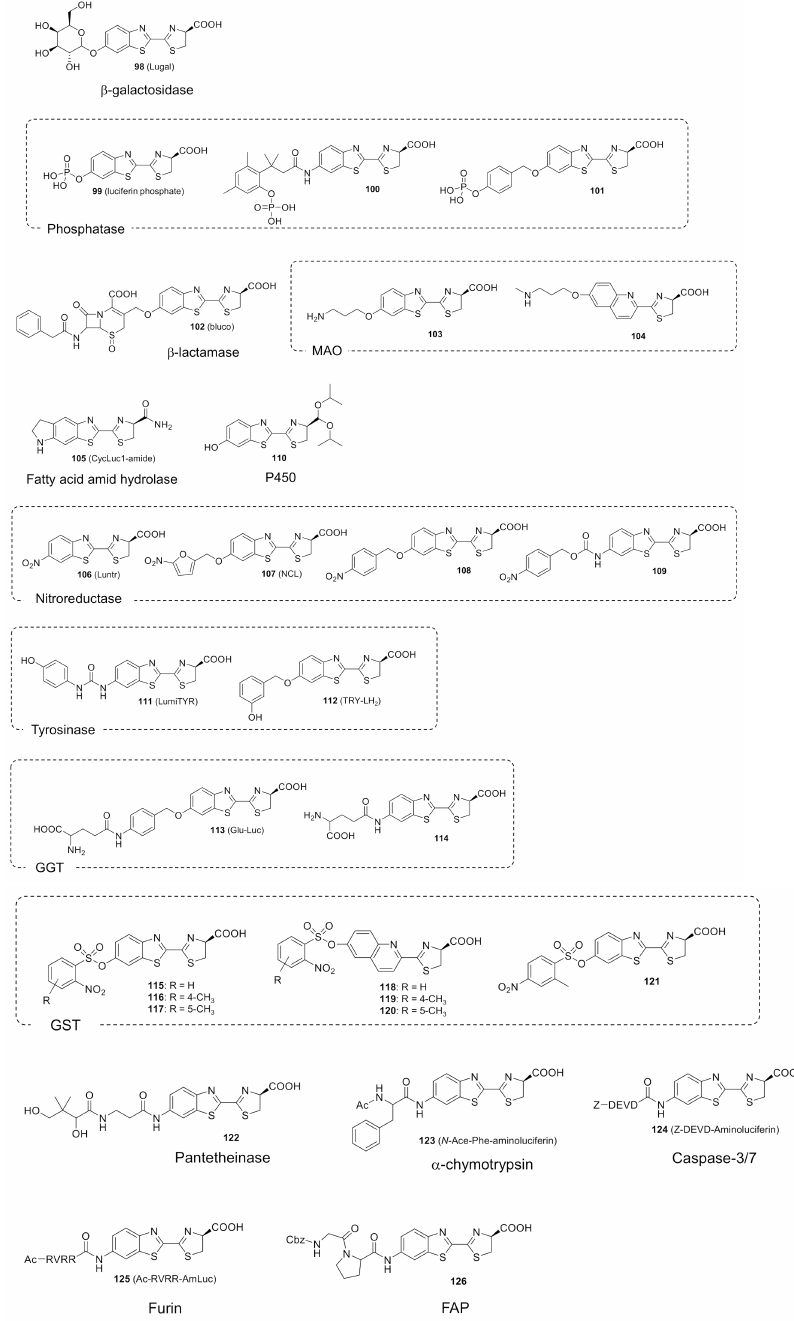
Figure 6. Chemical structures of bioluminescence probes for the detection of enzyme